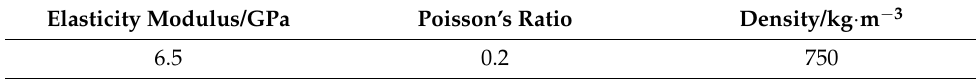
Table 1. Material parameters of the bottom